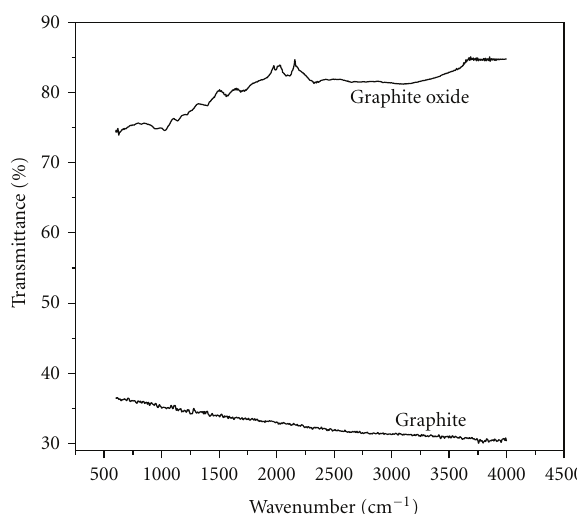
Figure 2: FTIR spectra of graphite and graphite